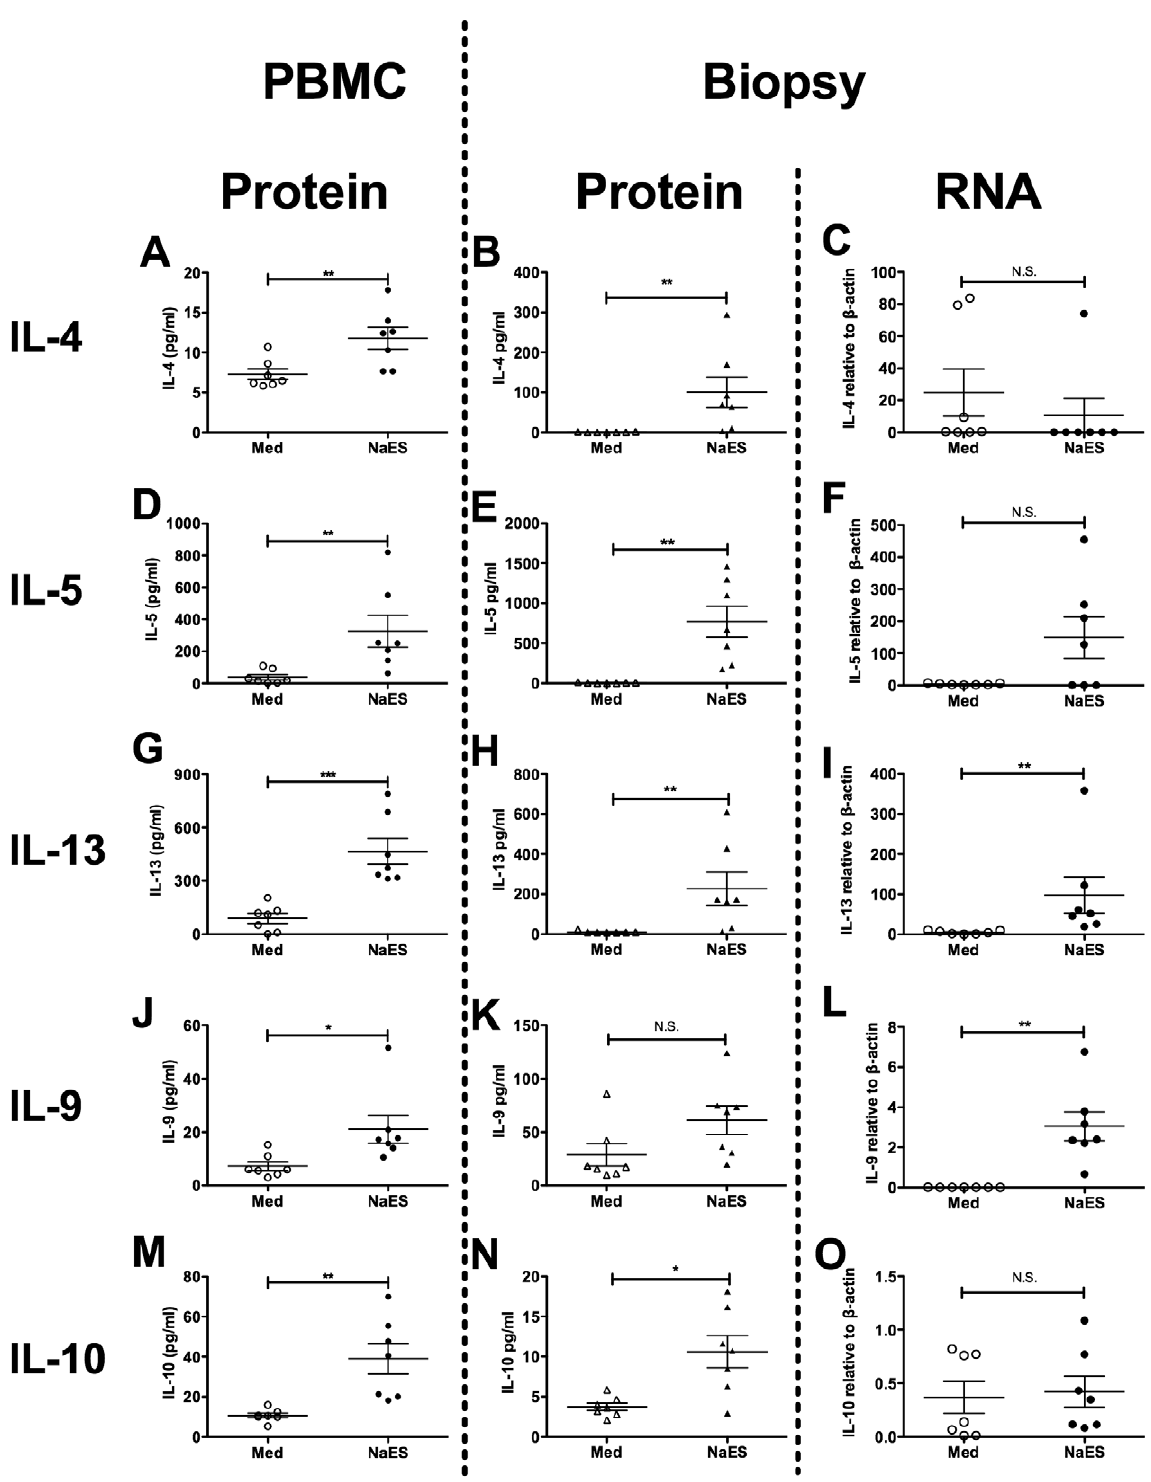
Figure 5. Systemic and mucosal hookworm specific immune responses. Peripheral blood mononuclear cells (PBMCs) from Trial 2 were cultured for 120 h with either tissue culture medium (Med) or Med containing 10 m g/ml Necator americanus ES products (NaES). Duodenal biopsies were also taken at week 20 post-infection, and cultured for 24 h at 37 u C, 95% O2/5% CO 2 , in either Med alone or 10 m g/ml NaES in Med. Cell-free supernatants were taken from both PBMCs and biopsy cultures and levels of soluble cytokines were determined by cytometric bead array. RNA was also prepared from biopsies after stimulation and quantitative real time RT-PCR was used to determine levels of cytokine gene transcripts. Soluble cytokines released from PBMCs are shown in panels A, D, G, J and M. Biopsy-derived soluble cytokines are shown in panels B, E, H, K and N. Biopsy cytokine transcripts are shown in panels C, F, I, L and O. Cytokine levels determined were IL-4 (A–C), IL-5 (D–F), IL-13 (G–I), IL-9 (J–L) and IL-10 (M–O).